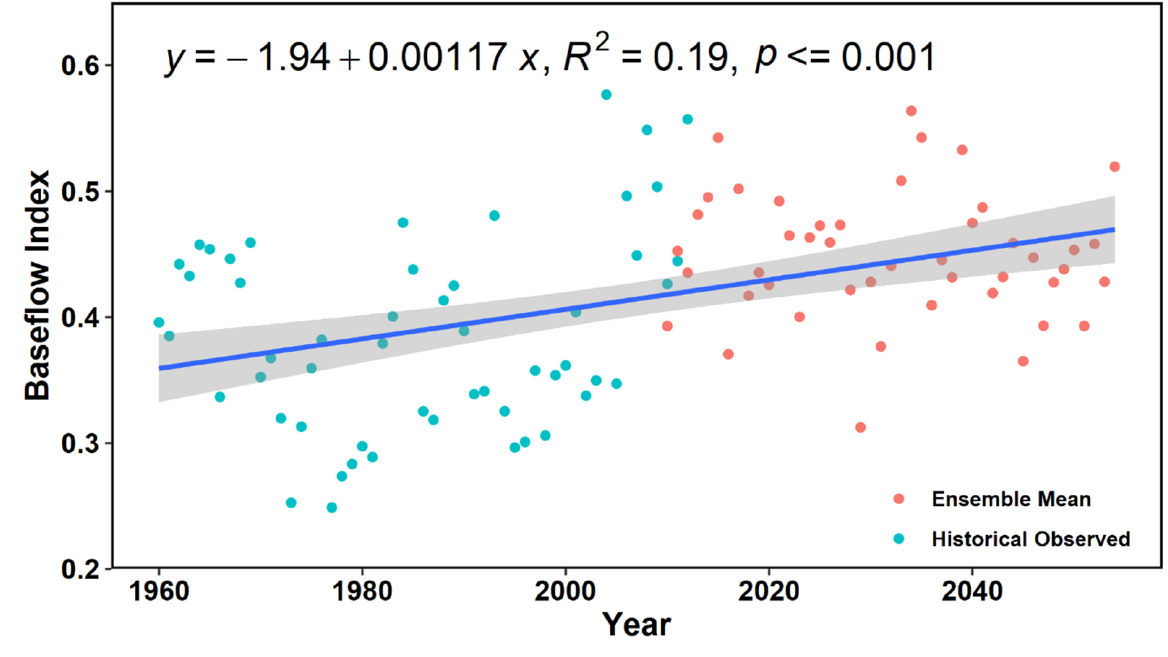
Figure 9. Variation in the baseflow index derived from historical observed streamflow data (1960–2010) and the ensemble means of three general circulation models for two scenarios (simulated from six models) for the future climate changes (2010–2054). The line and equation represent a linear regression.